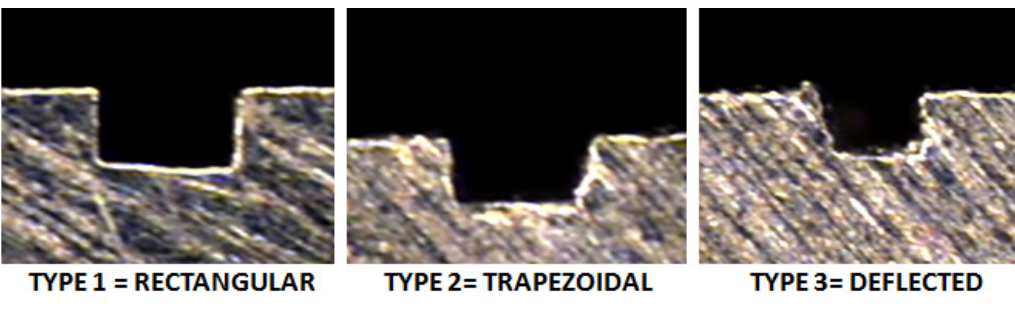
Figure 14. Coolant and a coolant and ( b ) high a